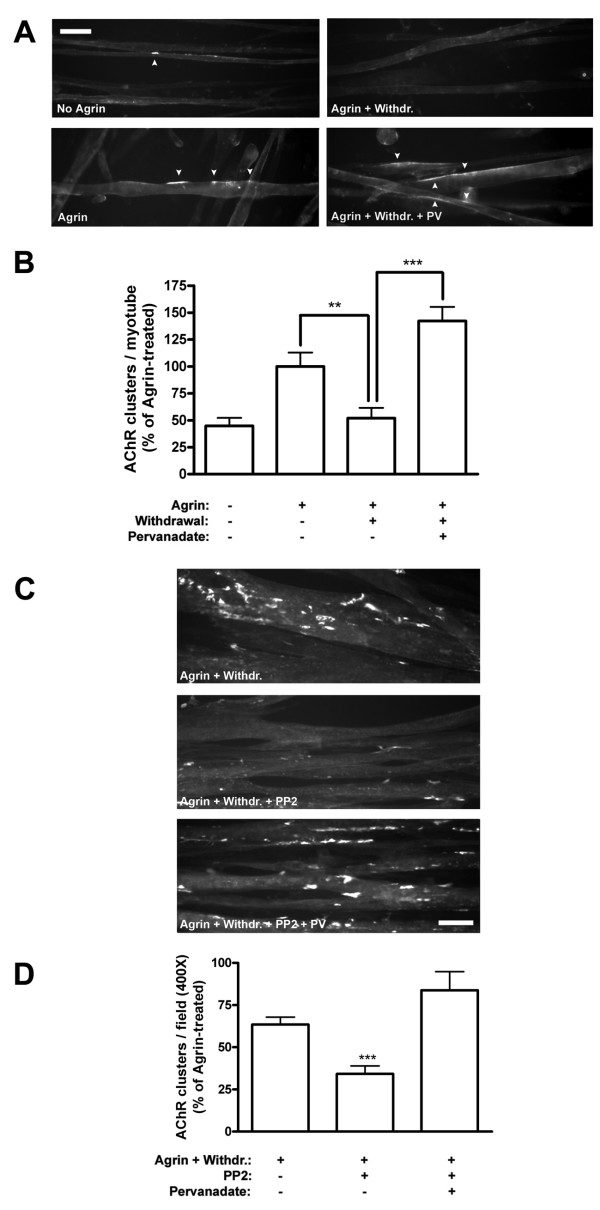
AChR cluster stability is rescued by PTP inhibition in src-/-;fyn-/- myotubes and PP2-treated C2C12 myotubes. (A) PTPs were blocked with 20 μM pervanadate in src-/-;fyn-/- myotube cultures at the point of agrin withdrawal for a period of 5 h (Agrin + Withdr. + PV), following agrin treatment for 16 h. As controls, myotubes were either left untreated (No Agrin), treated with agrin for 16 h (Agrin) or treated with agrin followed by withdrawal for 5 h (Agrin + Withdr.). AChRs were stained with rhodamine-α-BTX and analyzed by fluorescence microscopy. Scale bar, 40 μm. White arrowheads indicate AChR clusters. (B) The number of AChR clusters per myotube is shown as the percentage of clusters in agrin-treated src-/-;fyn-/- cells (Agrin) (means ± SEM; N = 15 from three similar experiments; **p < 0.01, ***p < 0.001 by two-tailed paired t test). Pervanadate restores cluster stability following agrin withdrawal in src-/-;fyn-/- myotubes. (C) The inhibitor PP2 was used to block SFK activity in C2C12 myotubes. Myotubes were treated with agrin for 6–8 h in the presence of 10 μM PP2 for the last 2 h (these 2 h were chosen to ensure that PP2 was effective at the point of agrin withdrawal). Agrin was removed and myotubes incubated with agrin-free medium in the presence of pervanadate and PP2 for 16 h (Agrin + Withdr. + PP2 + PV). In controls, cultures were treated with agrin followed by withdrawal for 16 h in the presence or absence of PP2 (PP2 was added 2 h before agrin removal) (Agrin + Withdr.; Agrin + Withdr. + PP2). AChRs were stained with rhodamine-α-BTX, analyzed by fluorescence microscopy. Scale bar, 40 μm. (D) The number of AChR clusters per field (400× magnification) was calculated, as described in Figure 1, as the percentage of agrin-treated C2C12 cells (Agrin) (not shown) (means ± SEM, N = 30 from three experiments). *** indicates significant difference to the other two bars (p < 0.001; two-tailed paired t test). Blocking SFKs with PP2 reduces the stability of pre-existing clusters in C2C12 myotubes, and pervanadate restores the stability to normal levels.